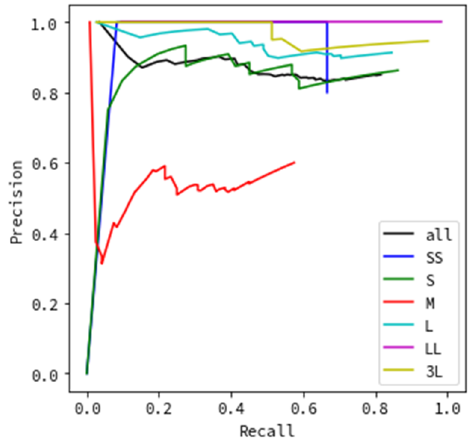
Figure 8. Detection precision by flying object size (including categorization).